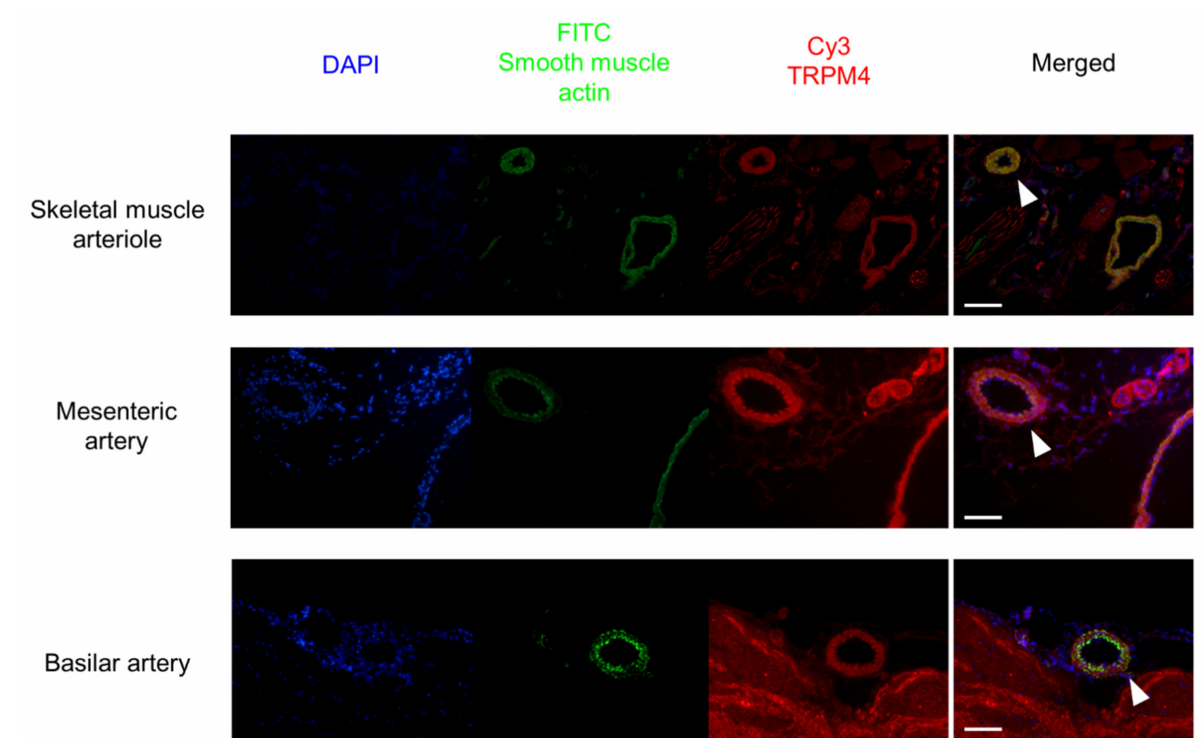
Figure 4. TRPM4 inhibitor 9-phenanthrol completely antagonizes norepinephrine-evoked increases in intracellular Ca 2+ concentrations and vasoconstrictions in skeletal muscle arteries. Pressure myography was performed on rat skeletal muscle arterioles. Blood vessels were loaded with Ca 2+ - sensitive fluorescent dye (fluo-4AM). Arterioles were pretreated with 10 µ M norepinephrine, which led to vasoconstriction, together with an increase in fluo-4 fluorescence of the vessel. 9-Phenanthrol was added to the organ bath, while external arteriolar diameter and wall fluorescence were measured and plotted on the graph. Black asterisks (*): p < 0.05 (Dunnett’s multiple comparison) vs. initial diameter. Grey hashes ( # ): p < 0.05 (Dunnett’s multiple comparison) vs. initial fluorescence. Symbols and bars are Mean ± SEM. Six ( n = 6) animals were used.